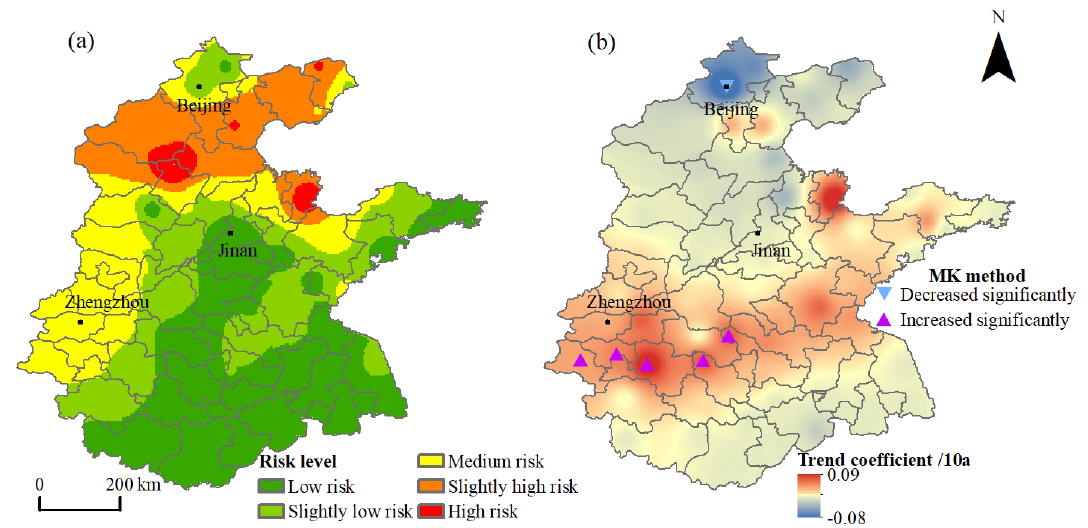
Figure 7. Distribution ( a ) and spatial change ( b ) of drought-induced risk on the North China Plain in summer from 2000 to 2018.